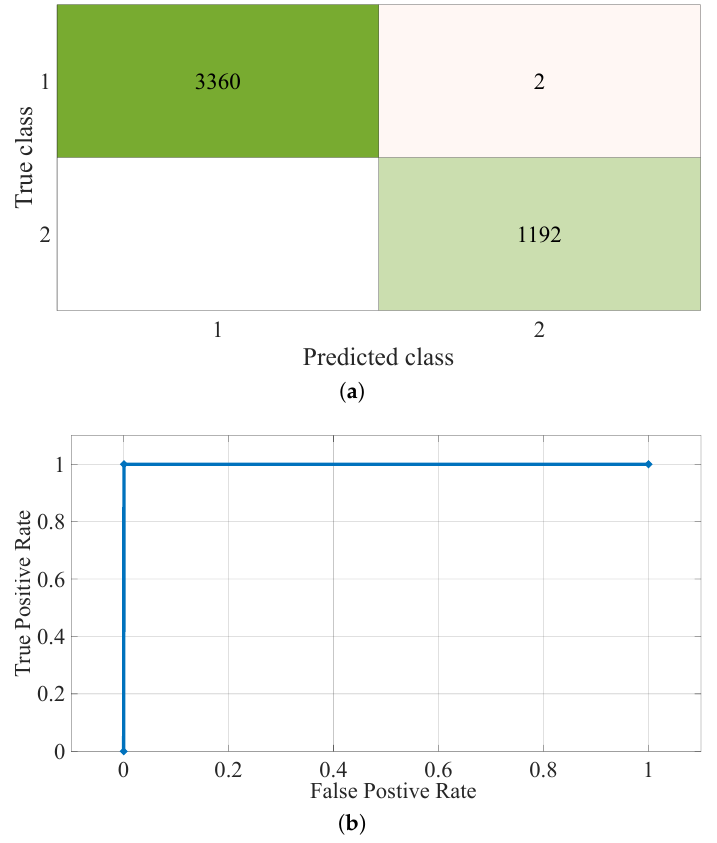
Figure 9. In-depth results for the selected third-order polynomial kernel for the ZigBee vs. all SVM classifier. ( a ) The confusion matrix for testing data. ( b ) The